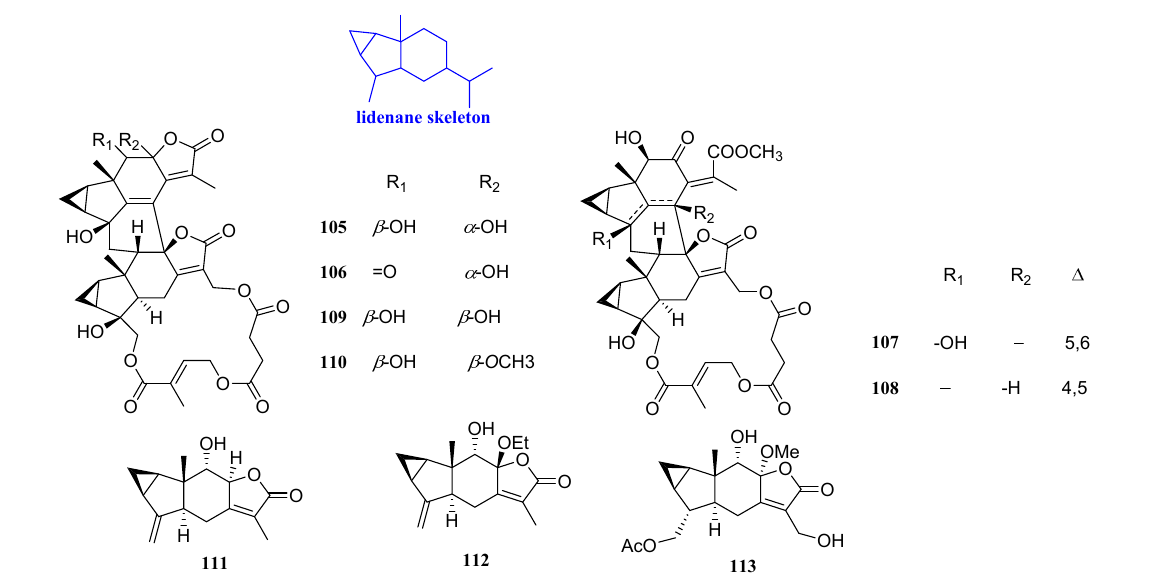
Figure 7. Structures of carotane - type sesquiterpenoids 93 – 104 .